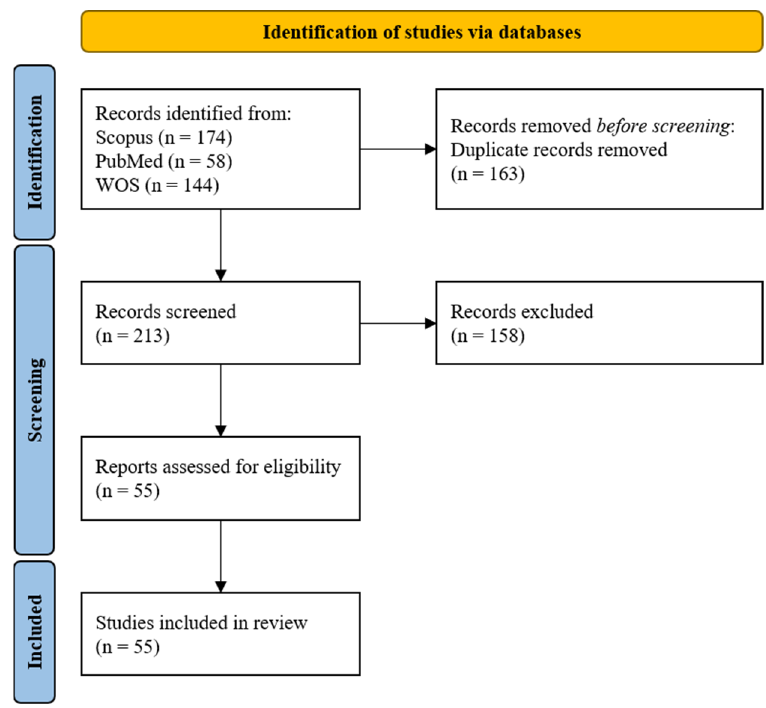
Figure 1. The PRISMA flow chart for the proposed literature review [36].